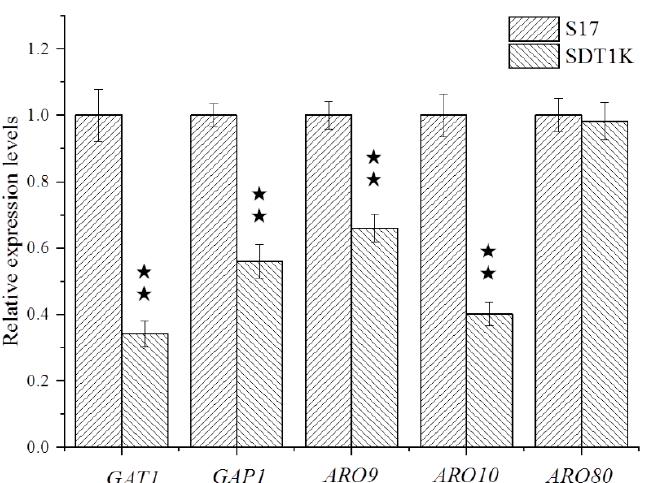
Figure 4. Determination of gene transcription levels in parental strain S17 and the mutant strain SDT1K . Total RNA of parental strains and mutants were isolated and used as the template to obtain the cDNA of GAT1 , GAP1 , ARO9 , ARO10 and ARO80 , which was used to determine the relative expression level of the corresponding gene by RT-qPCR. Data are the average of three independent experiments. Error bars represent ± SD. ★★ p < 0.01.